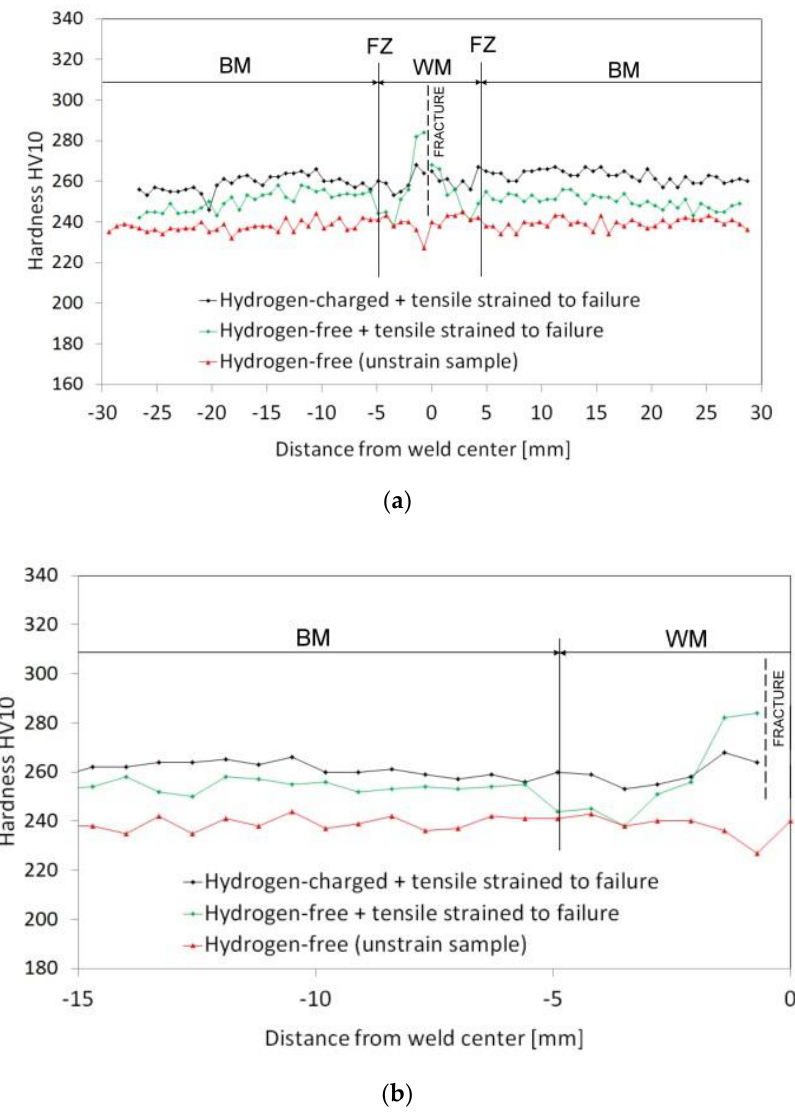
Figure 10. The effects of electrolytic hydrogenation and subsequent room-temperature tensile testing on cross-weld hardness profiles of T92/T92 weldments initially heat treated by renormalizing-and- tempering PWHT-2: ( a ) overall hardness profiles and ( b ) detailed hardness profiles focused on the former